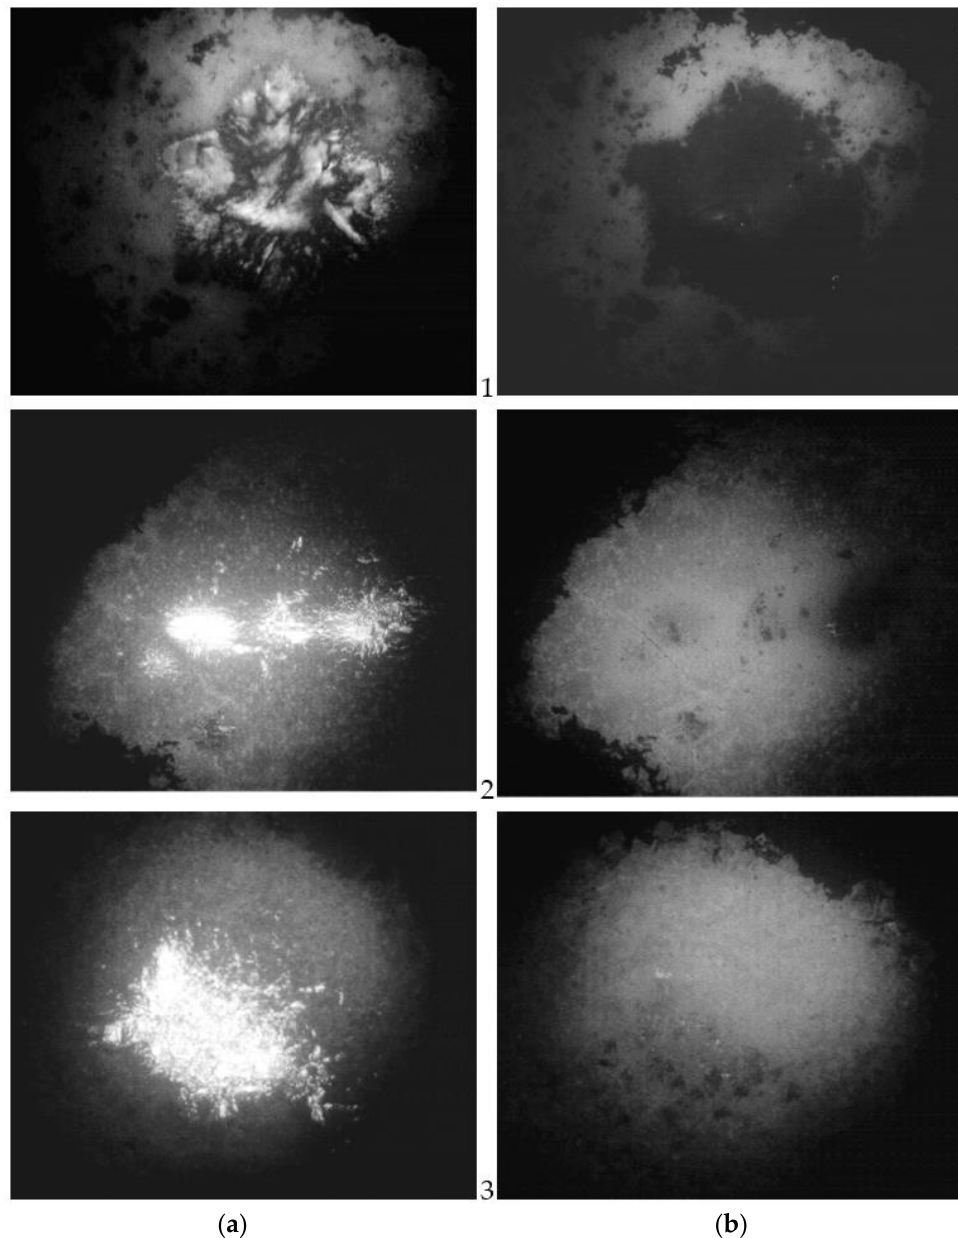
Figure 1. Micrographs of samples of phosphorus-containing dendrimers of generations G 2′ (1), G 4′ (2), and G 9′ (3) obtained at a temperature of 250 °C; under pressure ( a ) and without pressure ( b ). The polarizer was oriented from east to west. The analyzer oriented the direction of oscillation from north to south.